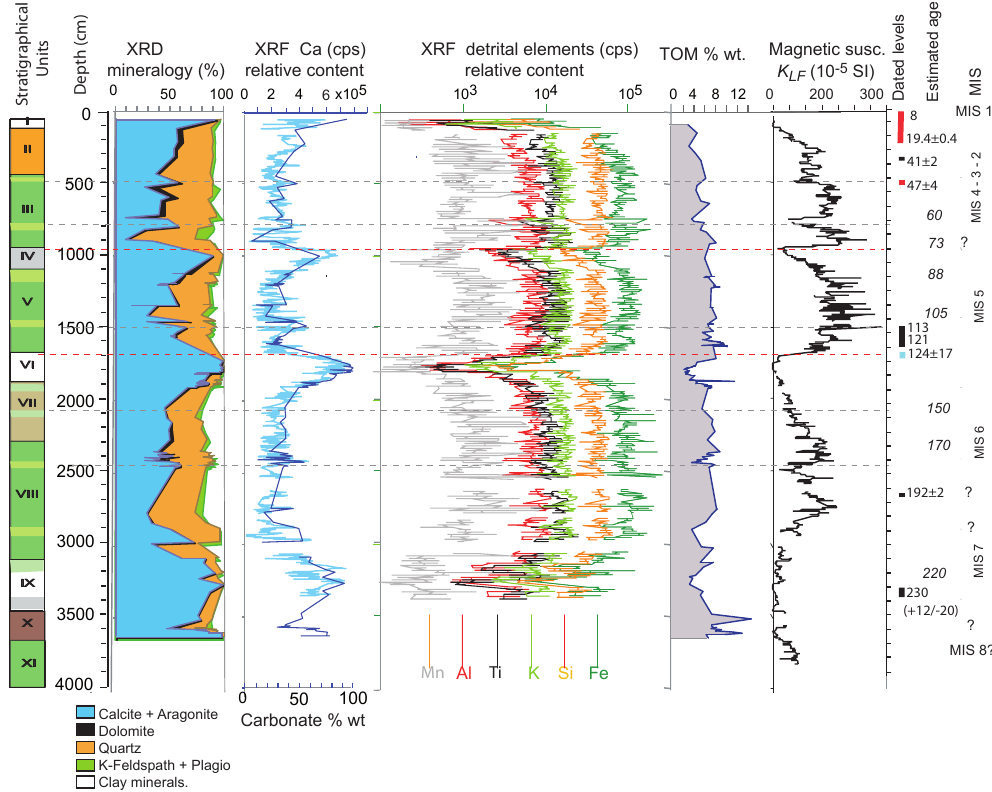
Fig. 5. Sedimentological data. Main proxies versus depth along the stratigraphical profile, after Develle et al. (2011). On the right, chronological information: position and measured ages of the chronological markers, estimated ages of major sedimentation changes (in italic, interpolated ages), and hypothesized relationships with Marine oxygen Isotope Stages (MISs; Martinson et al., 1987). Horizontal dashed lines: major (red) and second order (grey) sedimentation